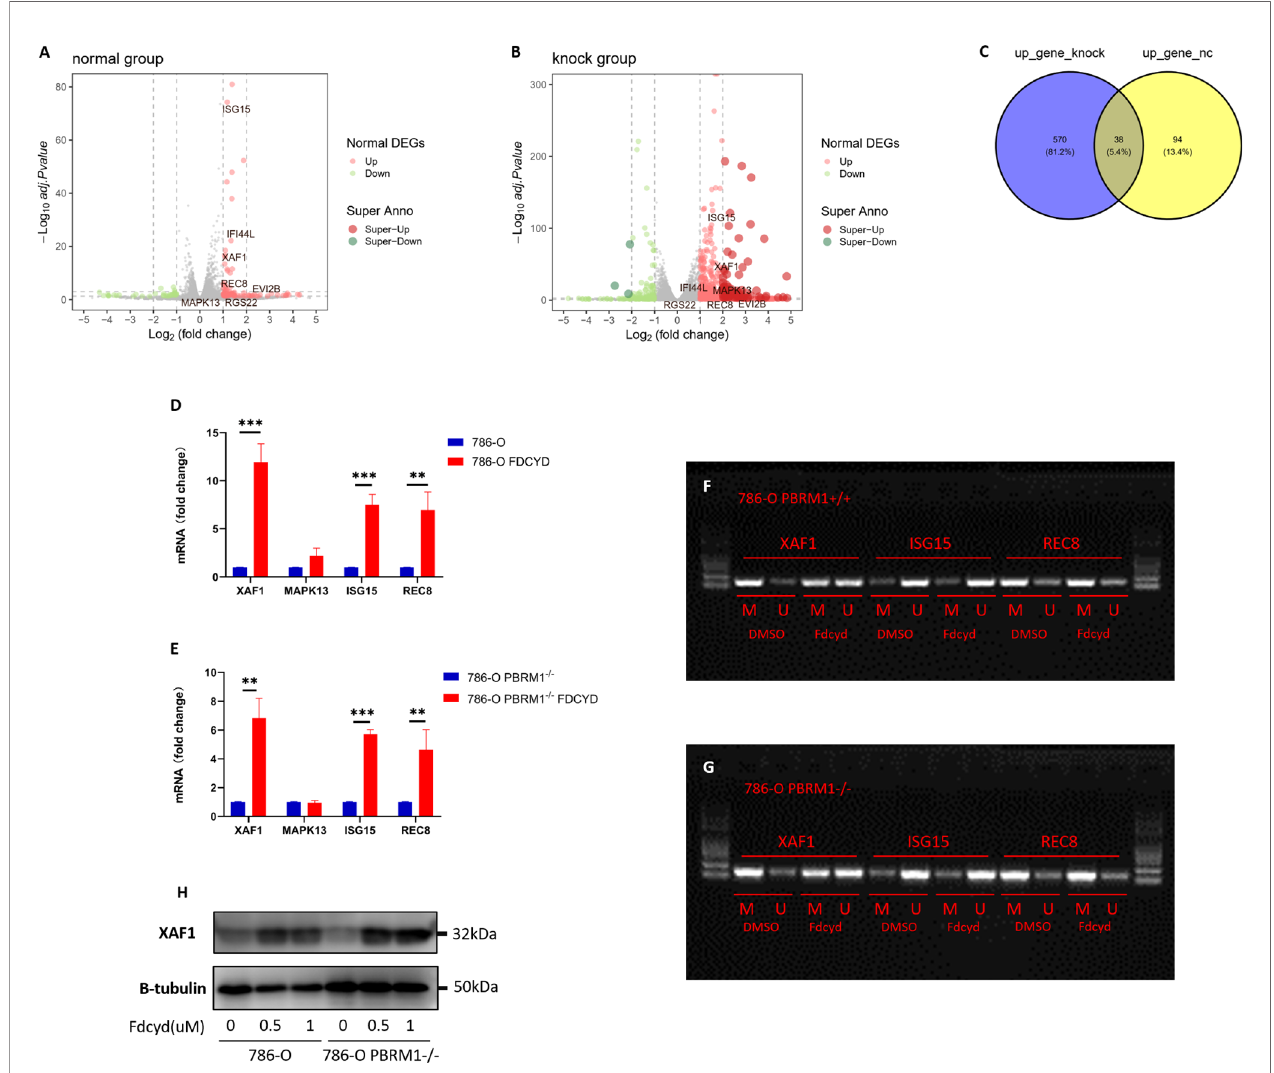
Fdcyd treatment group. (D, E) Relative mRNA expression level of the indicated genes as determined by qPCR. Data are mean ± SD of three independent experiments. **P<0.01, ***P < 0.001, student ’ s t test. (F, G) Methylation-speci fi c polymerase chain reaction con fi rmed demethylation of hypermethylated promoter region in 786-O isogenic cell pair. M, methylated DNA; U, unmethylated DNA. (H) Immunoblot analysis of XAF1. Data are mean ± SD of three independent experiments. **P<0.01***P < 0.001,